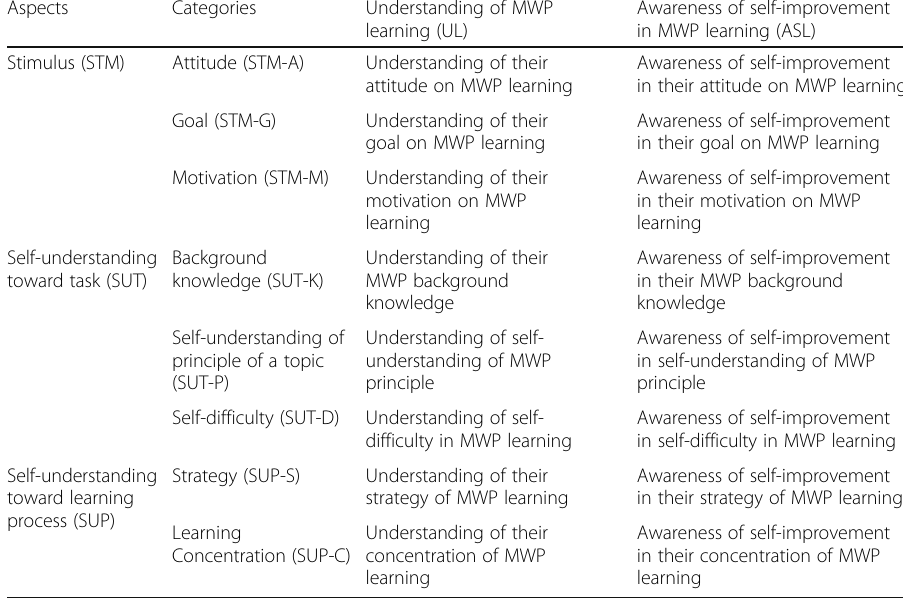
Table 2 Categories in each aspect of UL and ASL